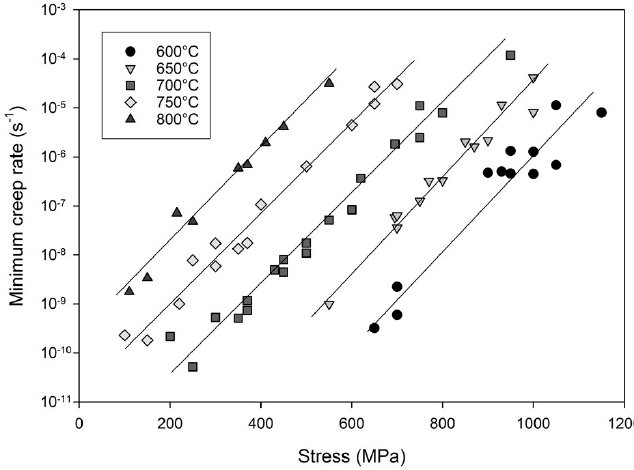
Figure 3. The relationship between stress and minimum strain rate in Waspaloy.